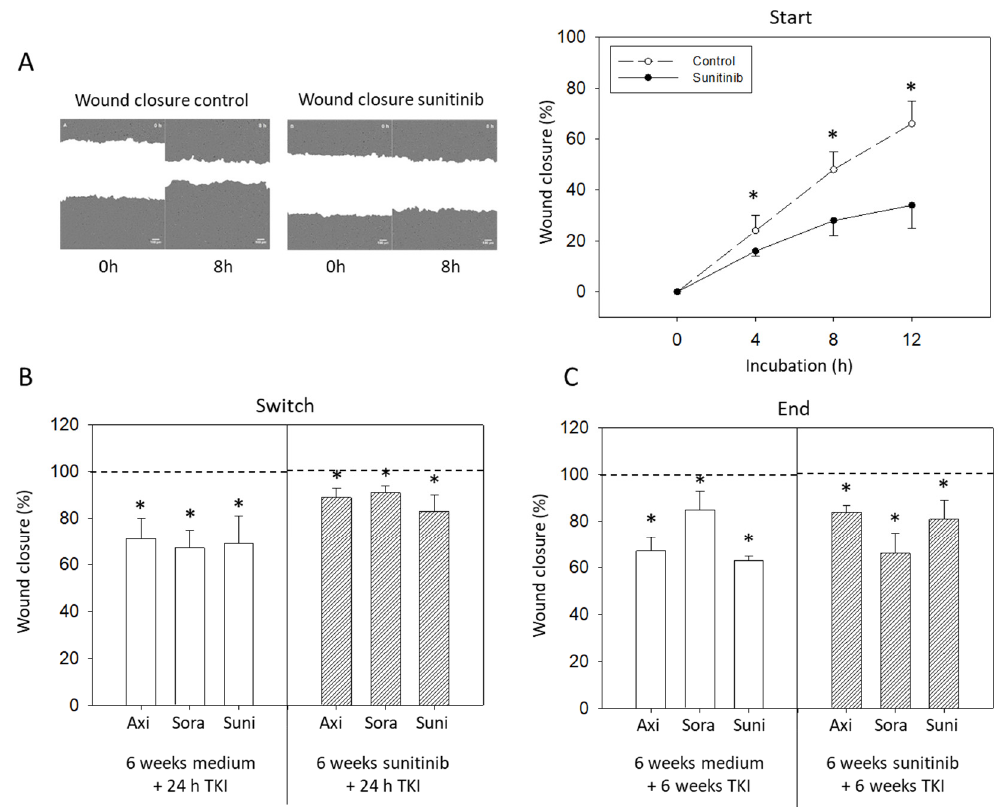
Figure 6. ( A ) Wound closure analyzed after 24 h sunitinib exposure and compared to untreated controls. One representative figure and the mean wound closure of treated versus untreated HUVECs are shown (n = 3). ( B ) Evaluation of wound closure after 6 weeks sunitinib (6 weeks sunitinib + 24 h TKI) or cell culture medium (6 weeks medium + 24 h TKI) followed by 24 h axitinib, sorafenib or sunitinib (Switch). Untreated controls were set to 100%. * indicates significant difference to the untreated controls. ( C ) Evaluation of wound closure after 6 weeks sunitinib (6 weeks sunitinib + 6 weeks TKI) or cell culture medium (6 weeks medium + 6 weeks TKI) followed by 6 weeks axitinib, sorafenib or sunitinib (End). Untreated controls were set to 100%. * indicates significant difference to the untreated controls.